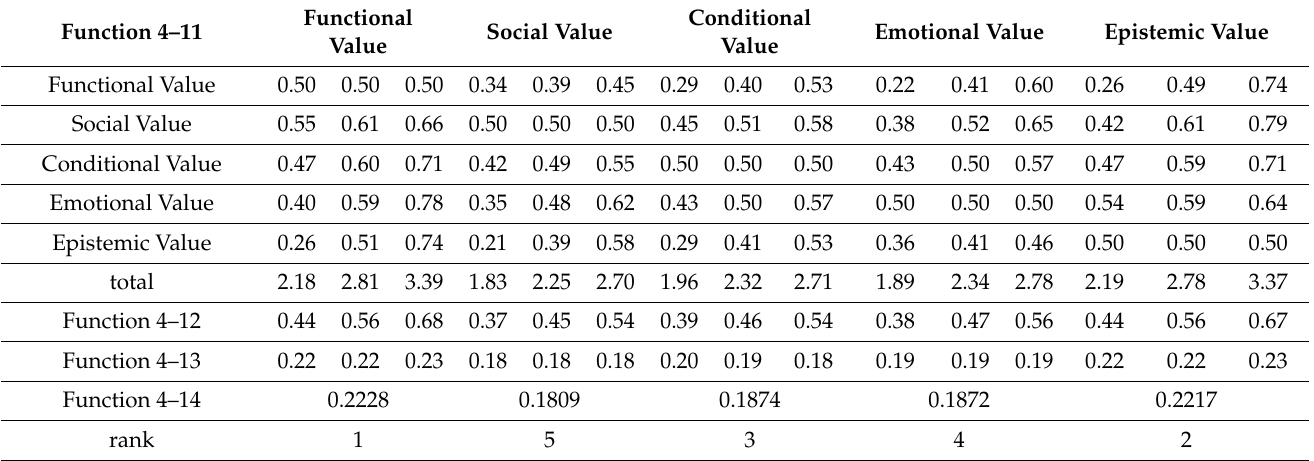
Table A2. Aviation companies’ weights of aspects of the service quality.